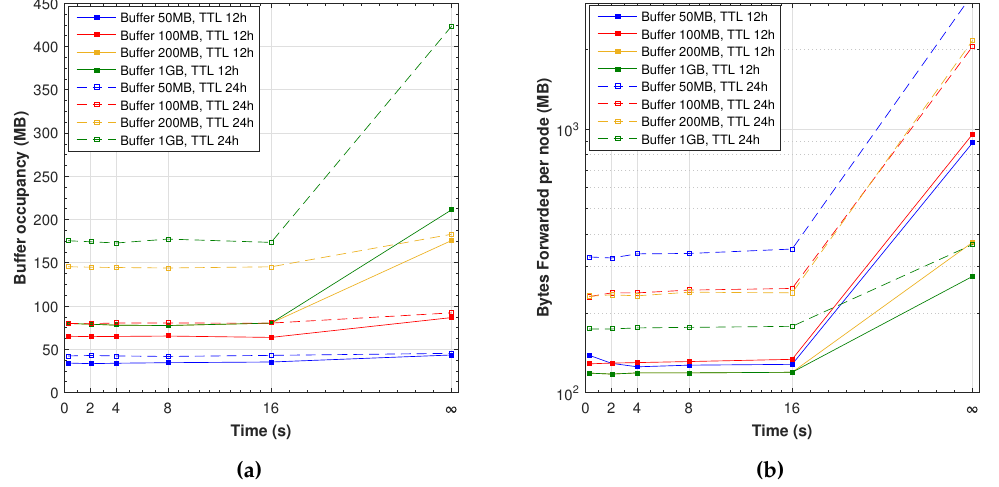
Figure 10. Overhead results: Buffer occupancy and forwarded bytes. ( a ) maximum of the average buffer occupancy from each node; and ( b ) average bytes daily forwarded per node ( y -axis in log